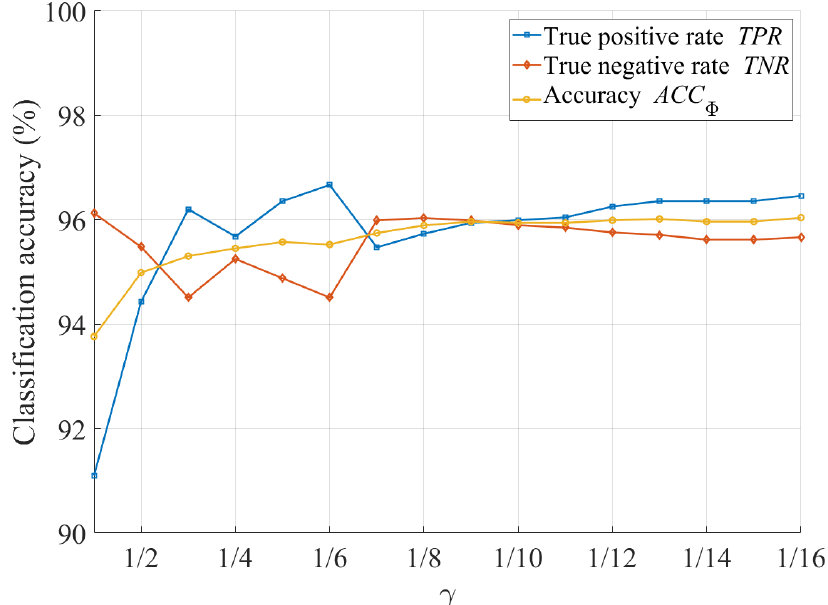
Figure 9. Classification accuracy as a function of γ .